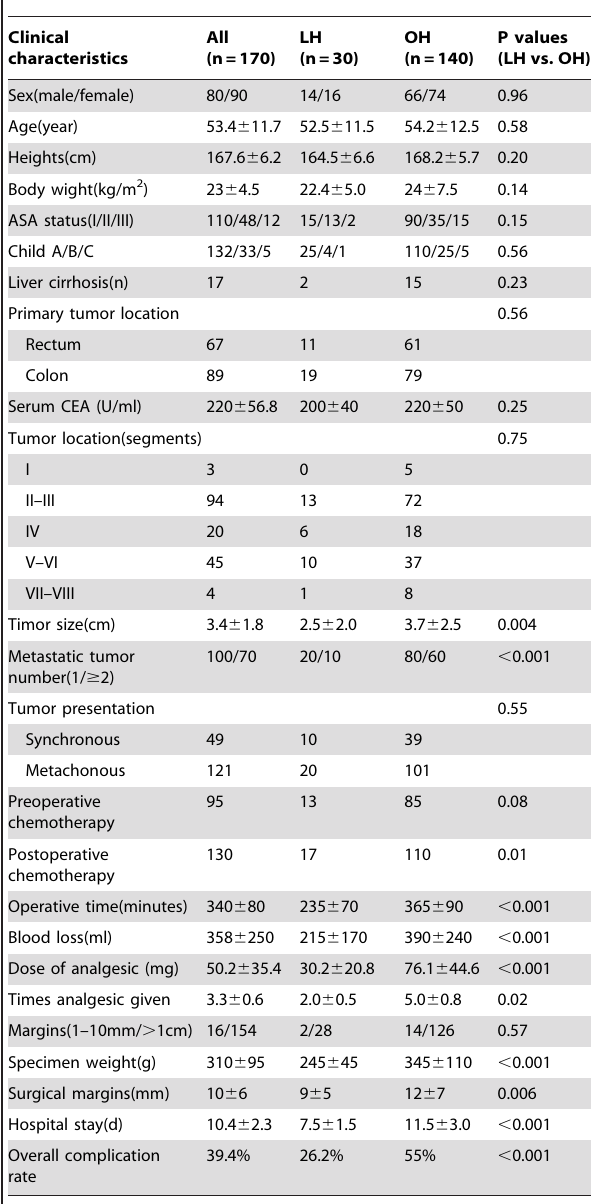
Table 2. Characteristics comparison of the 30 patients who underwent LH with matched 30 patients who underwent OH